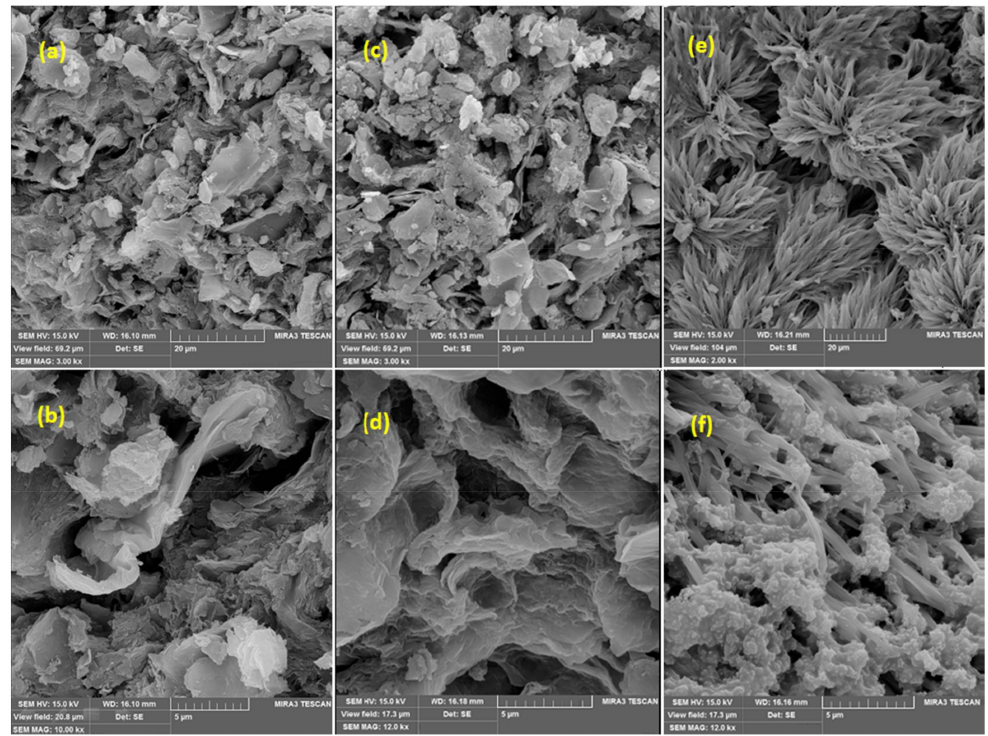
Figure 3. SEM images of GO/PAMAM at magnifications of ( a ) × 3k and ( b ) × 10k; CR-adsorbed GO/PAMAM at magnifications of ( c ) × 3k and ( d ) × 12k and GO/PAMAM at pH = 12 at magnifications of ( e ) × 2k and ( f ) × 12k.